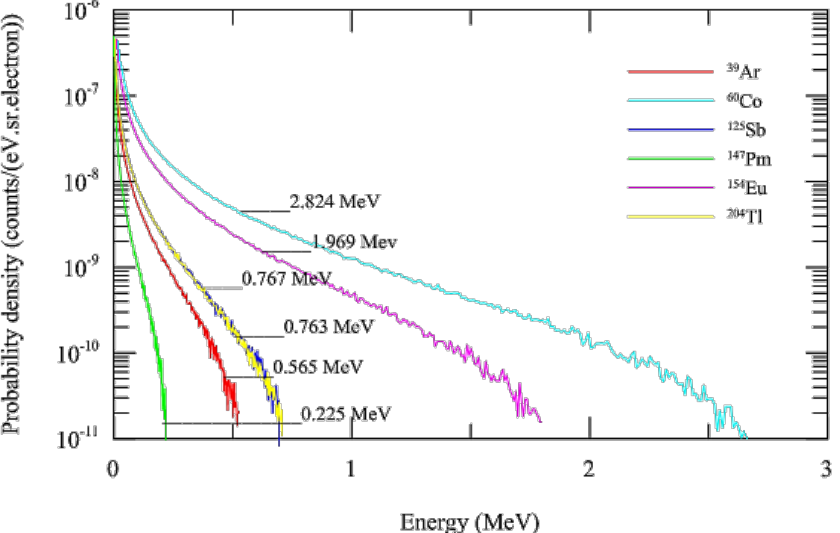
Fig.7: The comparison of the bremsstrahlung spectrums produced by absorption of target nuclei ( 39 Ar, 60 Co, 125 Sb, 147 Pm, 154 Eu and 204 Tl) beta particles into silicon